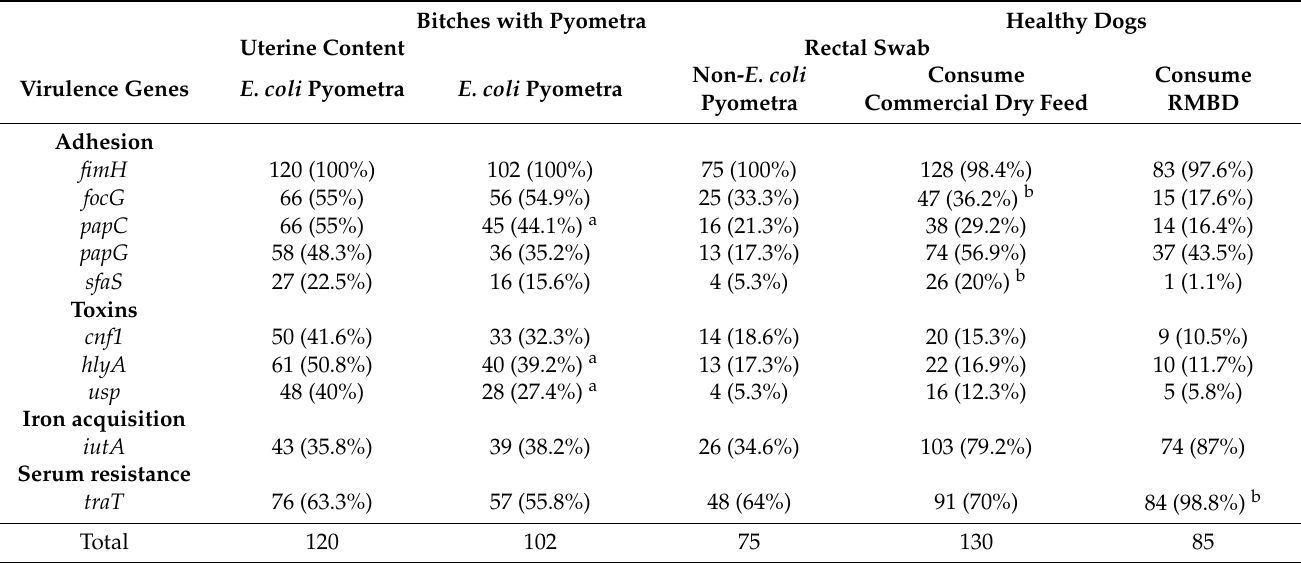
Table 3. Number of isolates and frequency of E. coli virulence genes identified in the uterine content, rectal swabs of bitches with pyometra and rectal swabs of healthy dogs. Bitches with Pyometra Healthy Dogs Uterine Content Rectal Swab Non- E. E. coli Pyometra E. coli Pyometra